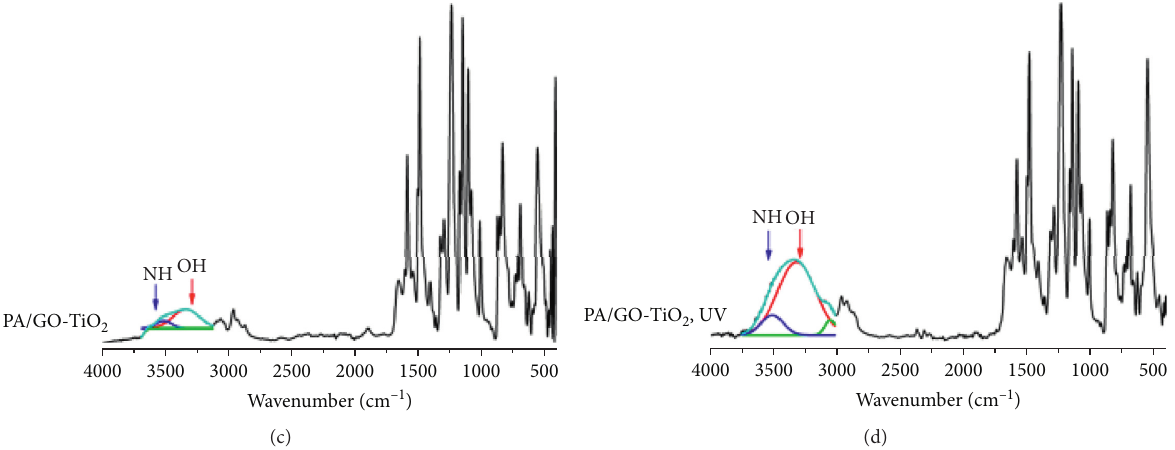
Figure 4: FTIR-ATR spectra of (a) PA, (b) PA/GO, (c) PA/GO-TiO 2 without UV light, and (d) PA/GO-TiO 2 with UV light membranes.